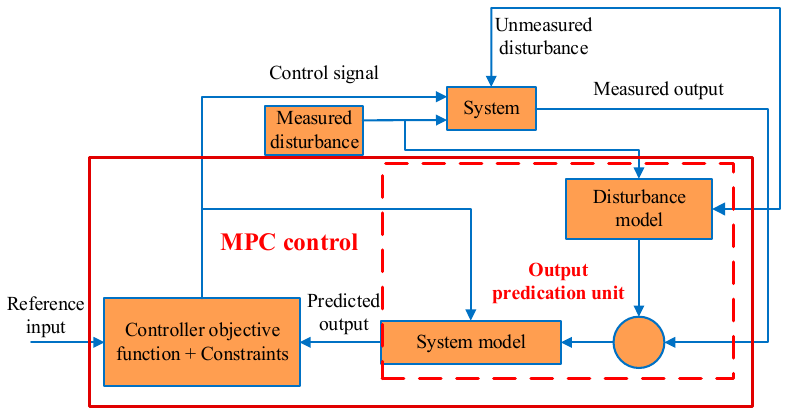
Figure 2. G eneral structure of model predictive control (MPC) scheme. Figure 2. General structure of model predictive control (MPC)